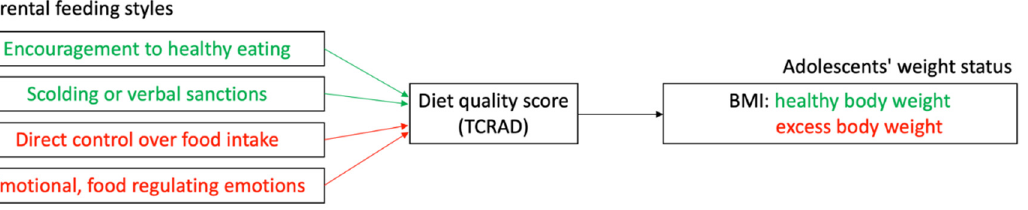
Figure 1. Conceptual model depicting the proposed associations between parental feeding styles (PFS) scores and adolescents’ weight status measured as body mass index (BMI) indirectly through the Traditional Costa Rica Adolescents Diet Score (TCRAD). Colors in the figure were assigned to reflect the hypothesized directionality of the proposed associations: green reflects an inverse asso- ciation between PFS scores and BMI, whereas red reflects a positive association between PFS scores and BMI.